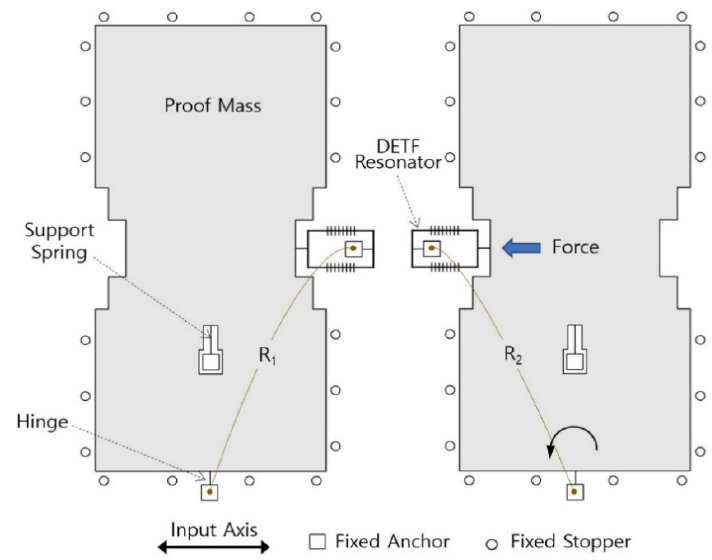
Figure 2. Schematic Diagram of the differential resonant accelerometers (DRA). DETF: double ‐ ended tuning fork.